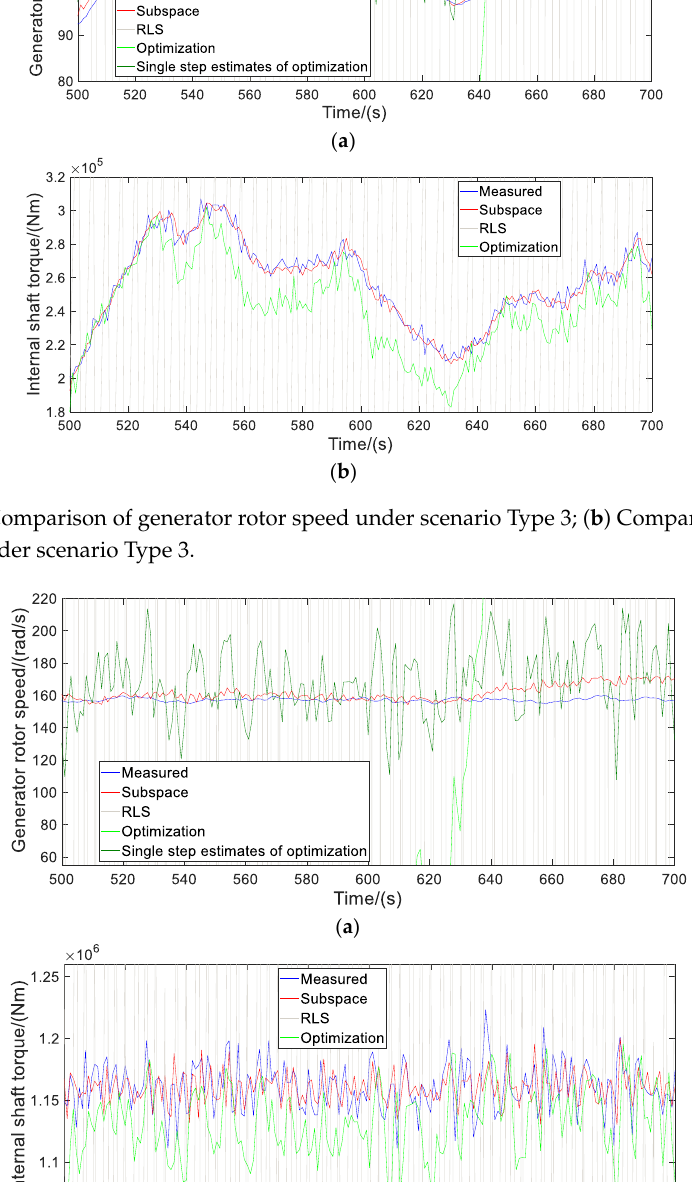
Figure 11. ( a ) Comparison of generator rotor speed under scenario Type 4; ( b ) Comparison of internal shaft torque under scenario Type 4.